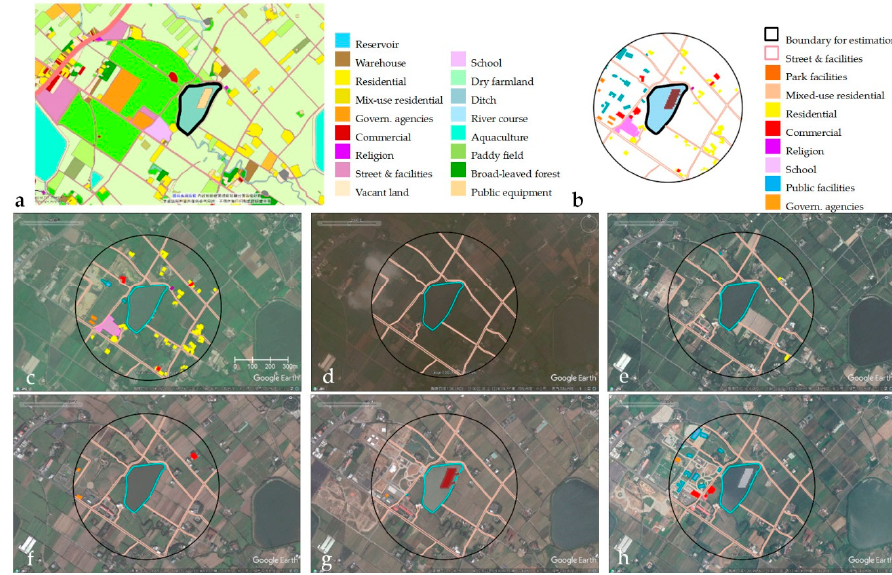
Figure 12. Land use districts ( a ) and building types ( b ) around the photovoltaic pond; highlighted area of modifications made on ( c ) 2009, ( d ) 2011, ( e ) 2013, ( f ) 2015, ( g ) 2017, and ( h ) 2019.